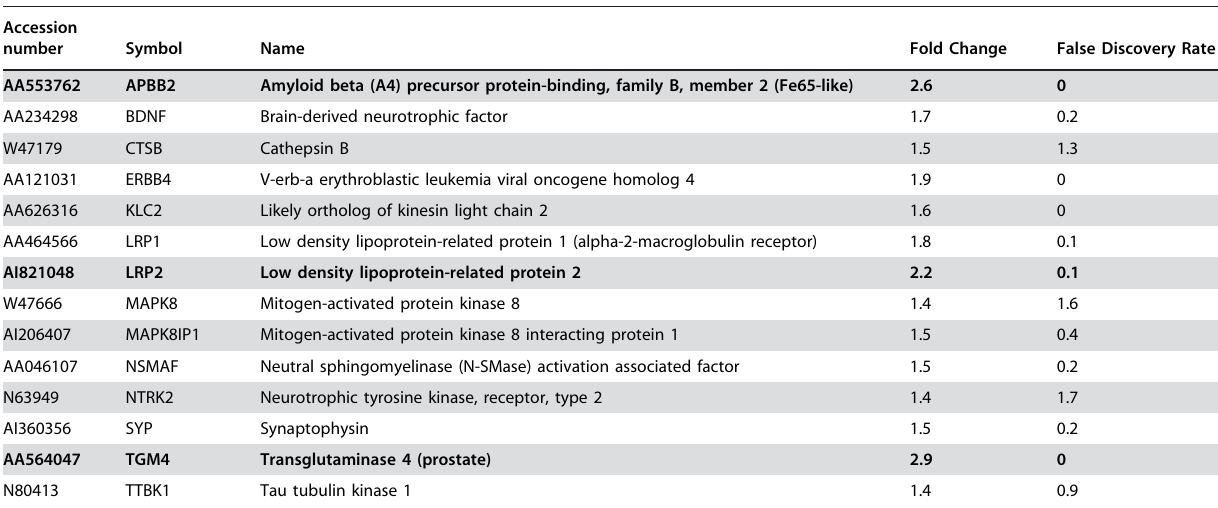
Table 2. Genes associated with Alzheimer’s disease are upregulated in NPC cells. .. ... .... ... ... .... ... ... .... ... ... .... ... ... .... ... ... .... ... ... .... ... ... .... ... ... .... ... ... .... ... ... .... ... ... .... ... ... .... ... ... .... ... ... .